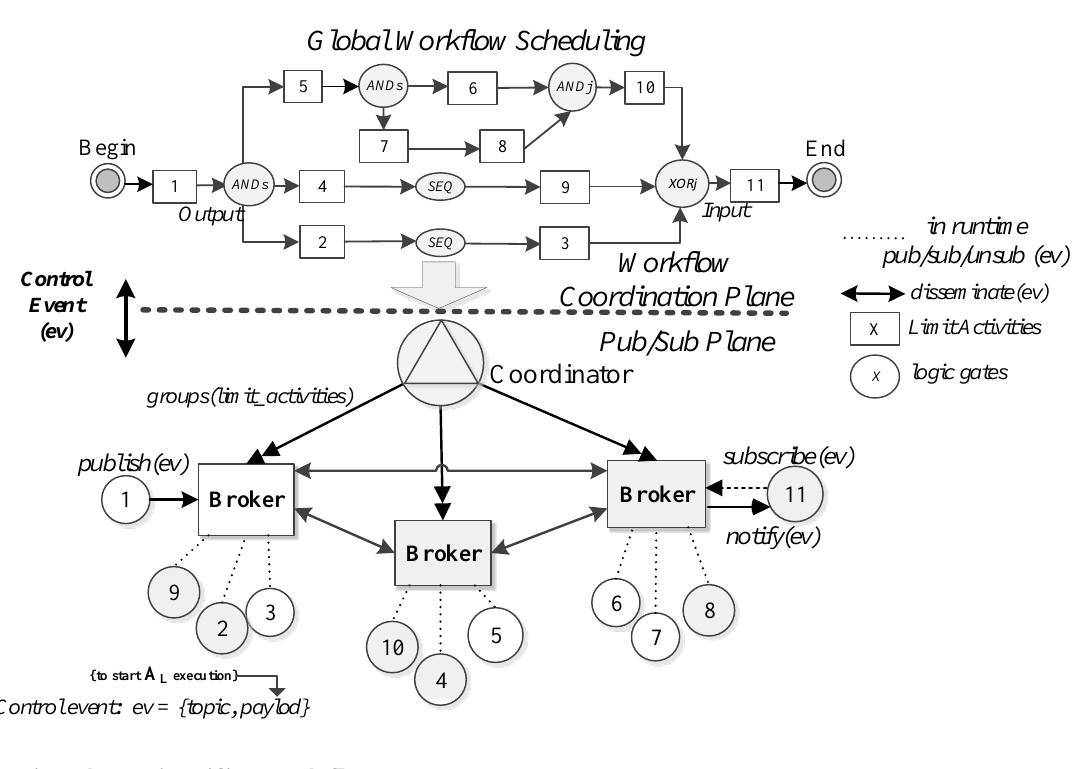
Figure 1. Workflow-to-Pub/Sub